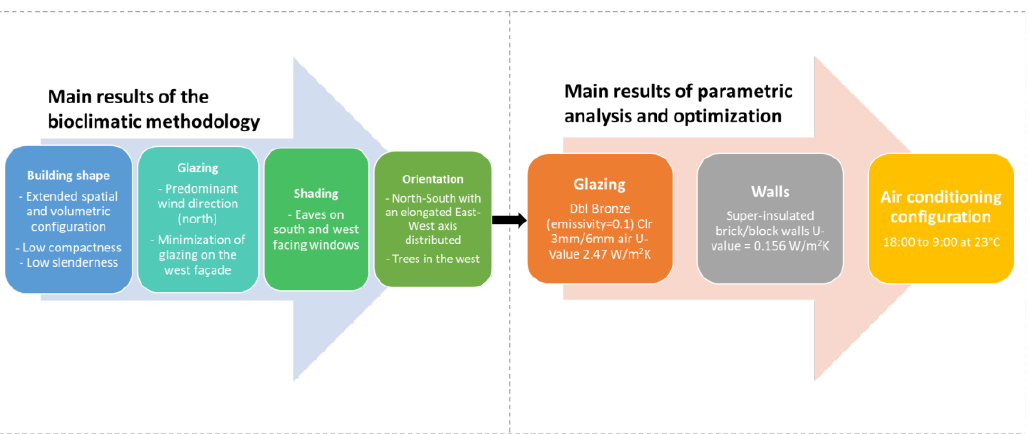
Figure 14. Main results compiled from the bioclimatic methodology and the parametric and opti- mization analyses.